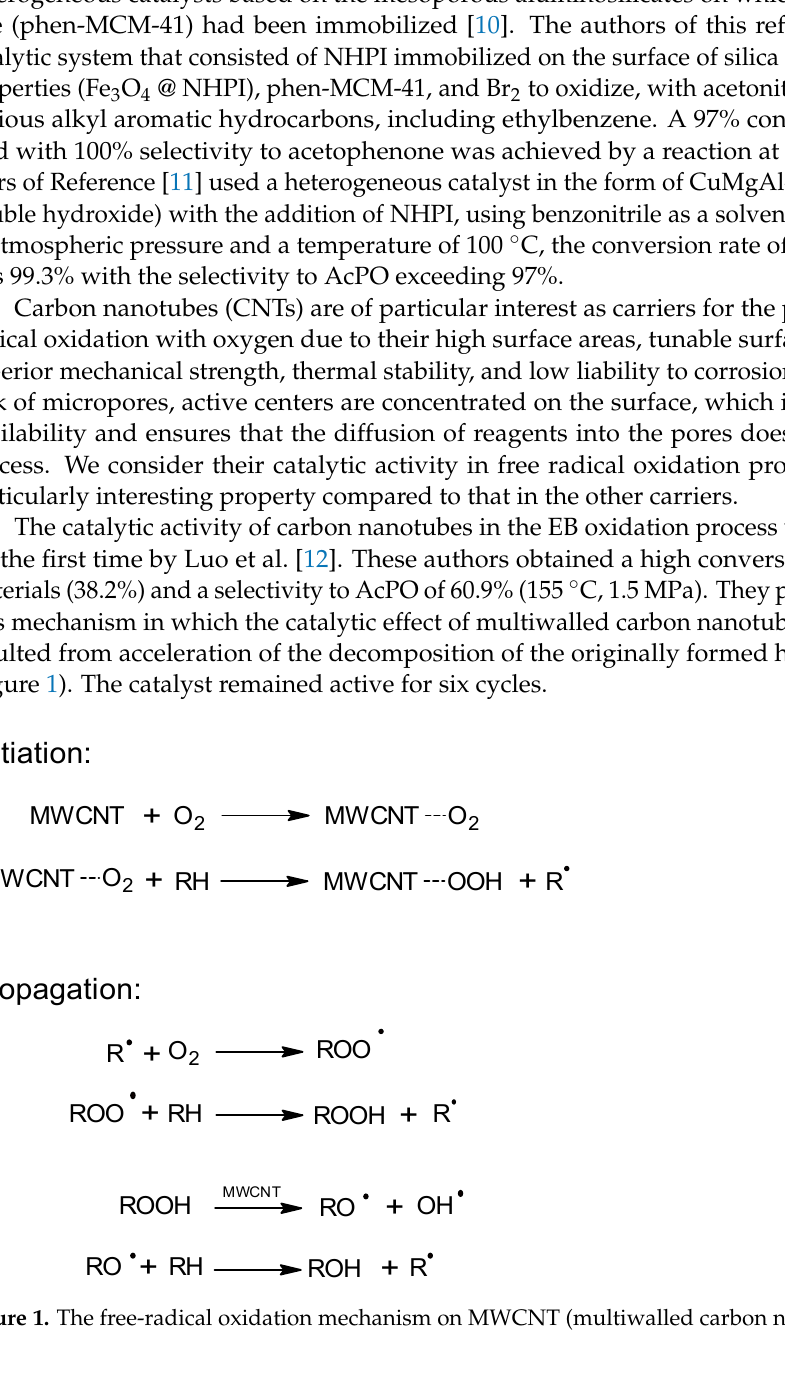
MWCNTs was only 3%. The study demonstrated the radical nature of the process. In ad- dition to the activity of MWCNTs in the hydroperoxide decomposition reaction, the au- thors also suggested that MWCNTs participate in the initiation of the process through the formation and subsequent decomposition of hydroperoxyl groups on the surface of nano- tubes. It was possible to recycle the catalyst over five consecutive reaction cycles while maintaining its activity. CNTs modified with heteroatoms have been used in the cyclohexane oxidation reac- tion [14], achieving high cyclohexane conversions of greater than 30%. For example, when the conversion was 34%, the selectivities of a mixture of cyclohexanol and cyclohexanone and of adipic acid were 40% and 52%, respectively. The possibility of recycling the cata- lyst, which was modified with nitrogen, was confirmed and achieved stable results with respect to the product selectivity in several subsequent reaction cycles. The activity of phosphorus-doped and boron-doped CNTs in this reaction was also noted [15]. Cao et al. synthesized CNTs by CVD (chemical vapor deposition method) from xylene by using do- pants: anilines to introduce additional nitrogen atoms into the CNT structure, triethyl- borate for the introduction of boron atoms, and triphenylphosphine for phosphorus. The significant differences in CNT morphology were noted. The reactions were carried out under a pressure of 1.5 MPa at 120 °C, with a 10% conversion of cyclohexane giving a 31% selectivity to adipic acid (0% for the reaction without the catalyst). The acid-functionalized CNTs have also been used as a metal catalyst support. One method was to soak the CNT with a solution of a suitable metal compound and then to dry it to evaporate the solvent. This method was used to prepare a catalyst, based on CNT and the Pt, Ru, and Cu compounds, for the aniline oxidation process with air [16]. The following metal salts were used: hydrogen hexachloro-platinum (IV) (H 2 PtCl 6 ∙ 6H 2 O), ru- thenium trichloride (RuCl 3 ∙ H 2 O), and copper (II) chloride (CuCl 2 ∙ 2H 2 O). For the reaction at 200 °C and at 2 MPa pressure, a slight increase in aniline conversion was achieved after the addition of nonmetallic CNTs and a large increase for metal-modified CNTs. Conver- sions of more than 60% were achieved for the Pt and Cu compounds. In the oxidation of ethylbenzene, nanotubes that were filled with nanowires made of iron atoms were used [17]. Nanomaterials with various Fe contents were synthesized and,